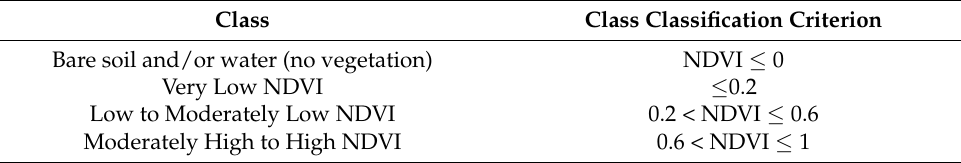
Table 2. Class Classification Standards for Description of NDVI Vegetation